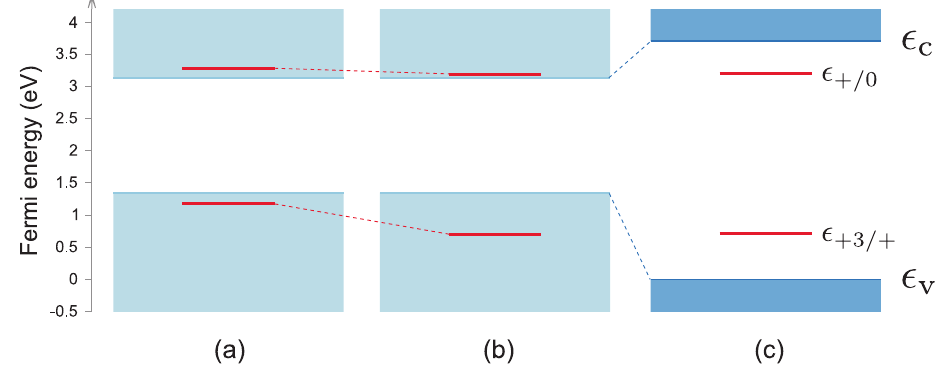
Fig. 2 Thermodynamic transition levels of V N in GaN, calculated with the PBE functional a without and b with fi nite-size corrections. In c , the HSE-calculated band gap is used, and the PBE-calculated transition levels are positioned by aligning the band edges through the average electrostatic potentials. (Reprinted from Ref. 54 with permission from